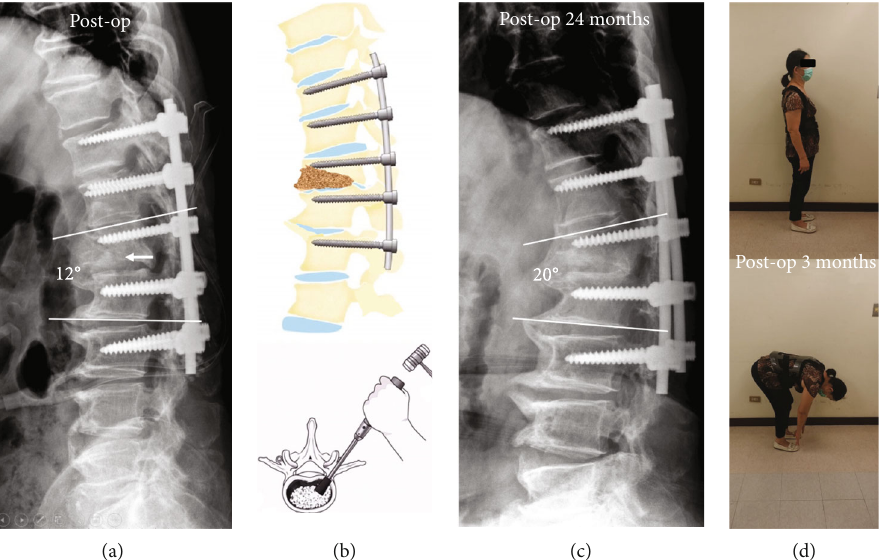
Figure 4: (a) Postoperative kyphotic angle improved immediately post operatively from 39 degrees to 12 degrees. (b) Allograft was impacted at the L1/T12 disc level. (c) The kyphotic angle stabilized at 20 degrees at three years follow-up. (d) At three months follow-up, back pain VAS had improved from 8 to 1 and the patient was able to bend forward without notable